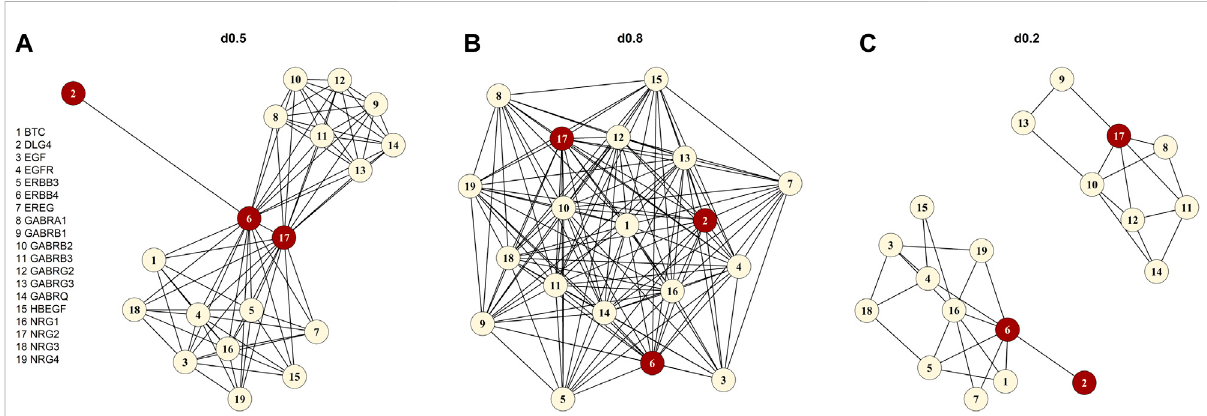
FIGURE 1 Graphical illustration of the “ signaling by ERBB4 ” pathway (A) original form without the chemical compound (d0.5), (B) the simulated high- density pathway (d0.8), (C) the arti fi cially createdlow-density pathway (d0.2). The red vertices are the three de fi ned causal genes (NRG2,ERBB4 and